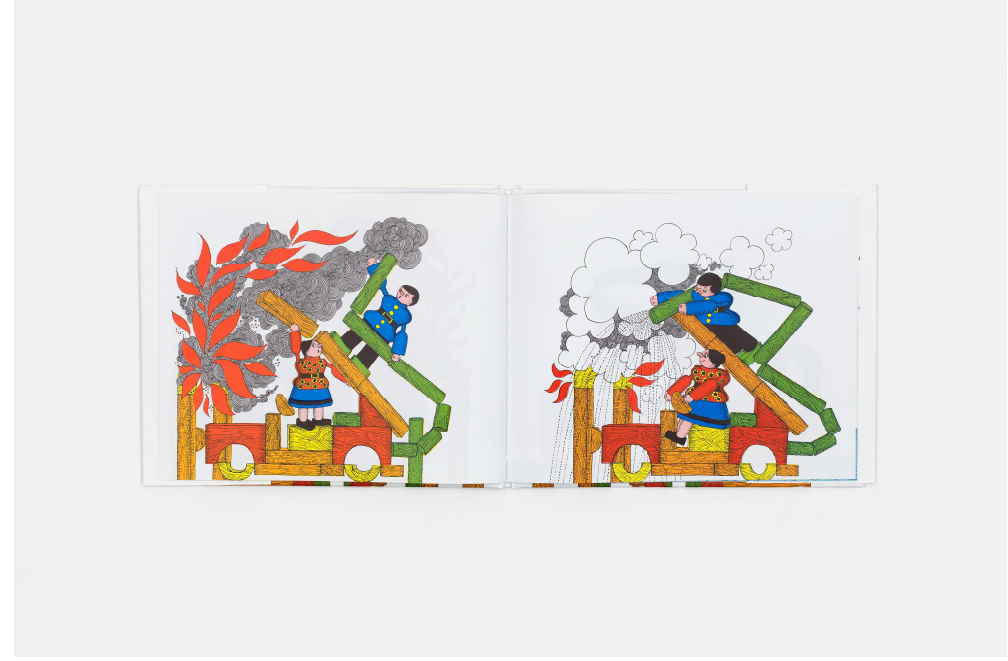
Figure 6. Hutchins P. (1971), Changes , Changes , Simon & Schuster, New